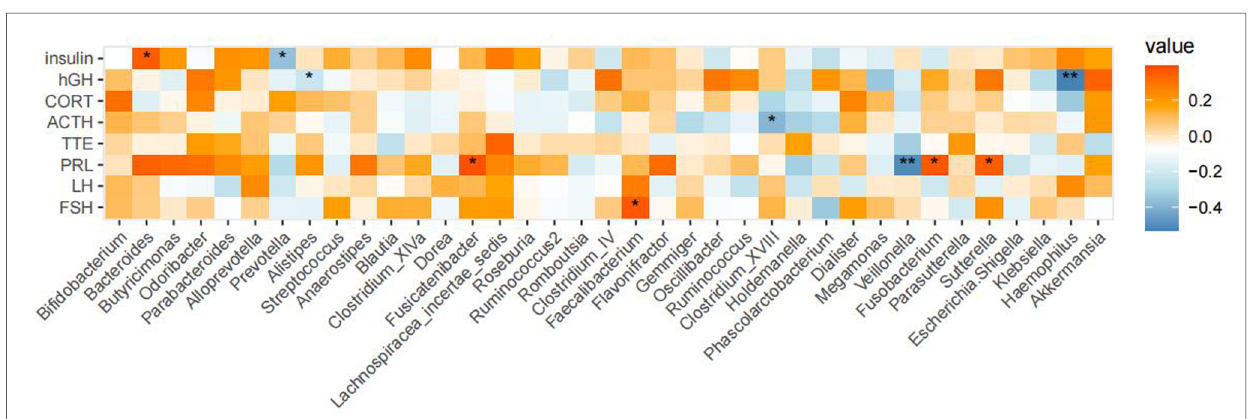
FIGURE 6 Correlations between GM compositions and endocrine hormones in children with GHD. Legend description: A correlation analysis was performed with eight clinical phenotypes and genera with a relative abundance of ≥ 0.1%. Results are shown as above where signi fi cance was expressed as * P <0.05 and ** P <0.01.